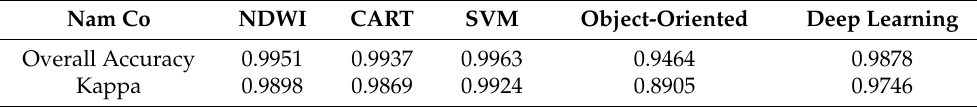
Table 5. Evaluation of the accuracy of Nam Co water extraction Table 6. Evaluation of the accuracy of Huaihe River Basin water extraction results.